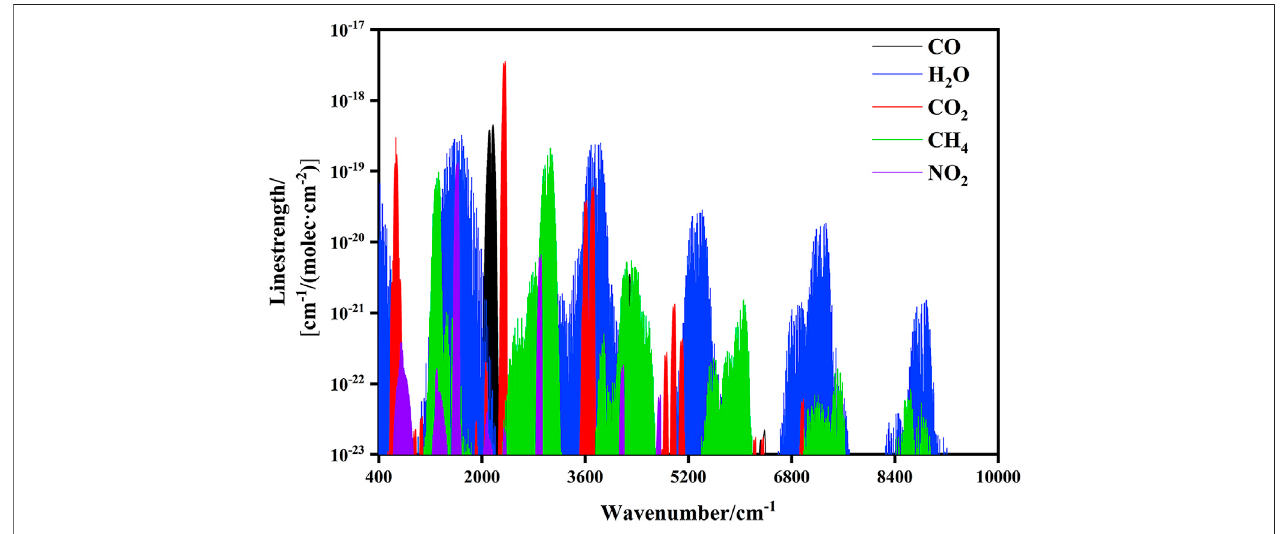
FIGURE 2 | Absorption lines of typical atmospheric species in the infrared. Data are taken from the spectroscopic database HITRAN.